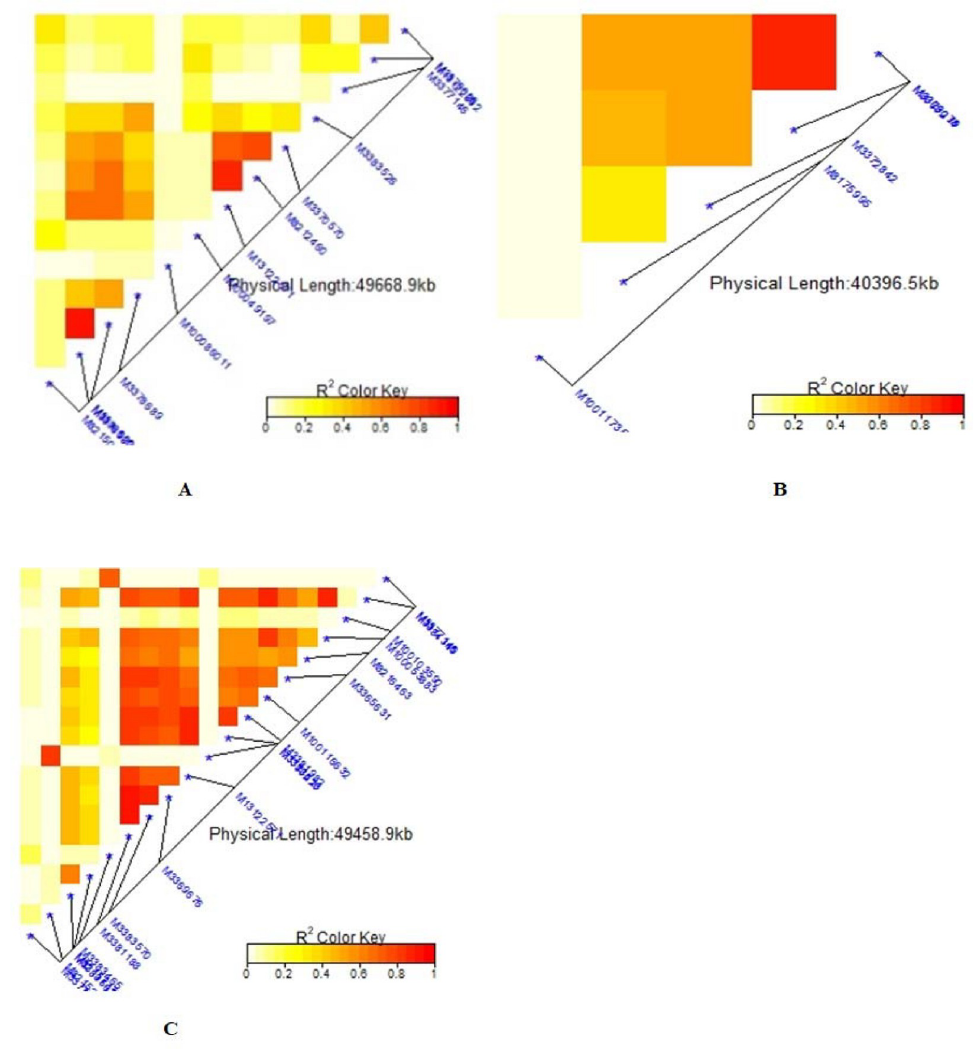
Fig 10. Summary of local LD among markers with significant marker trait associations of 99 common bean genotypes. Note: A = Number of pod per plant (NPP), B = Number seed per pod (NSP), C = Grain yield (GYD). The R 2 colour key indicates the degree of significant